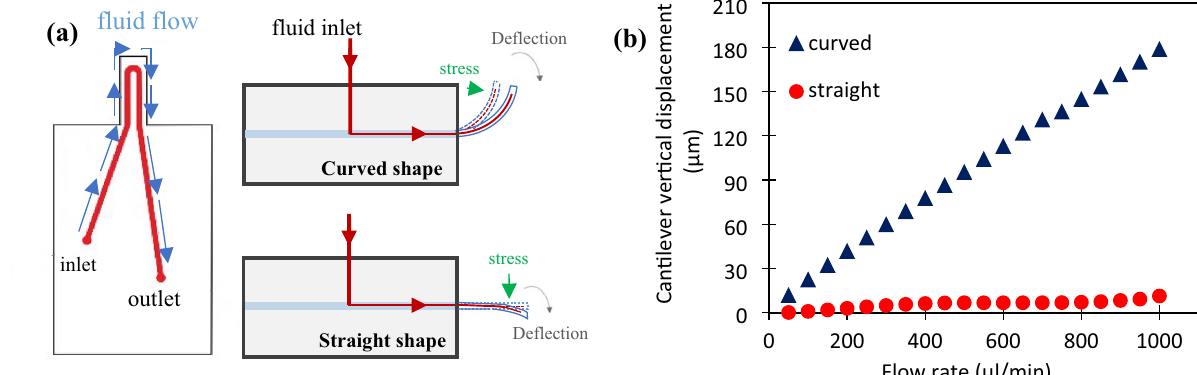
Figure 1. ( a ) The fundamental operational process of the flowmeter. ( b ) Comparison of the simulations results for the cantilever displacement in curved and straight shapes.